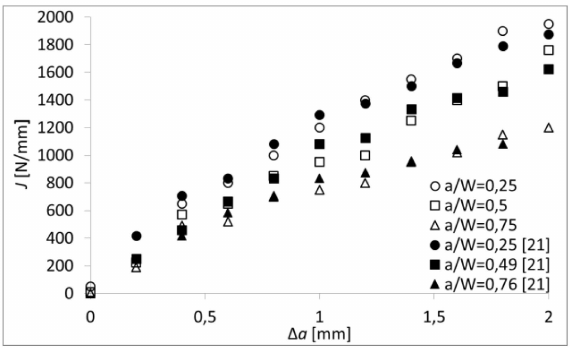
Figure 6. Comparison of numerically-predicted and experimentally-obtained J values for SENB specimens of 1.6310 steel.